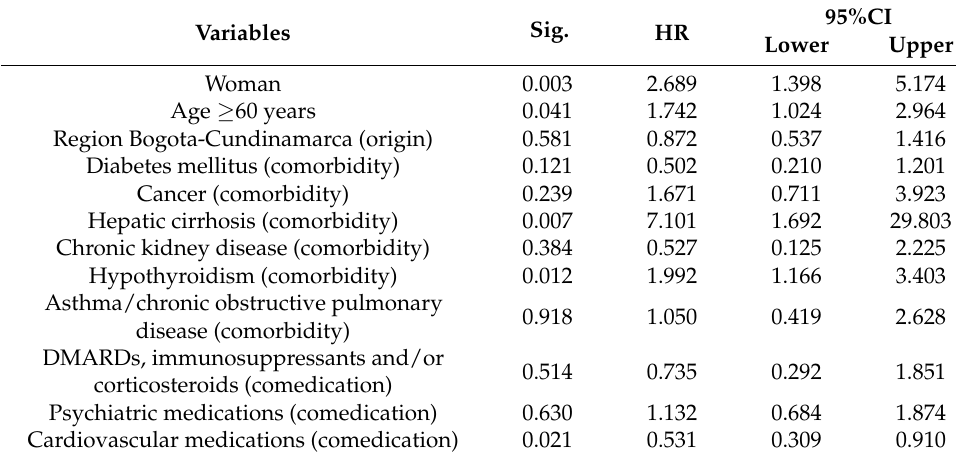
Table 3. Multivariate analysis using a Cox proportional hazards regression model of the variables associated with the probability of presenting a first recurrence of herpes zoster, in patients